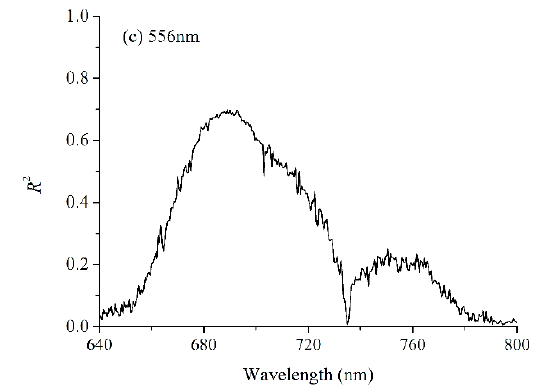
Figure 5. R 2 between the measured and predicted LNC with single wavelength fluorescence served as the input parameter to train the BPNN model for different excitation light wavelengths. ( a ) 355 nm, ( b ) 460 nm, ( c ) 556 nm.